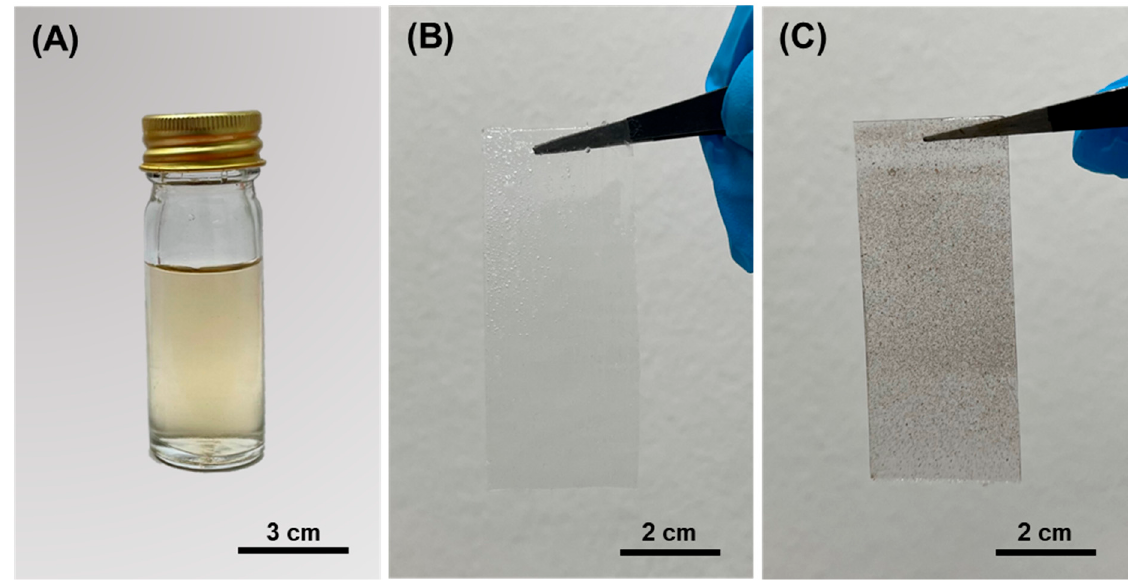
Figure 2. ( A ) Aqueous Ag particles from AgNO 3 with the addition of DMSO; the physical appearance of ( B ) pristine Si film and ( C ) Si–Ag thin film.